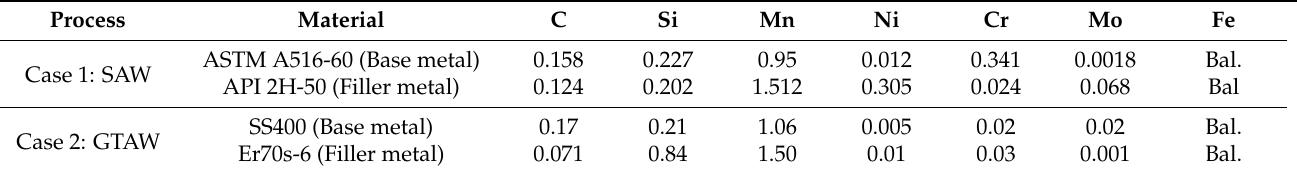
Table 2. Chemical composition of the base metal and filler metal for SAW and